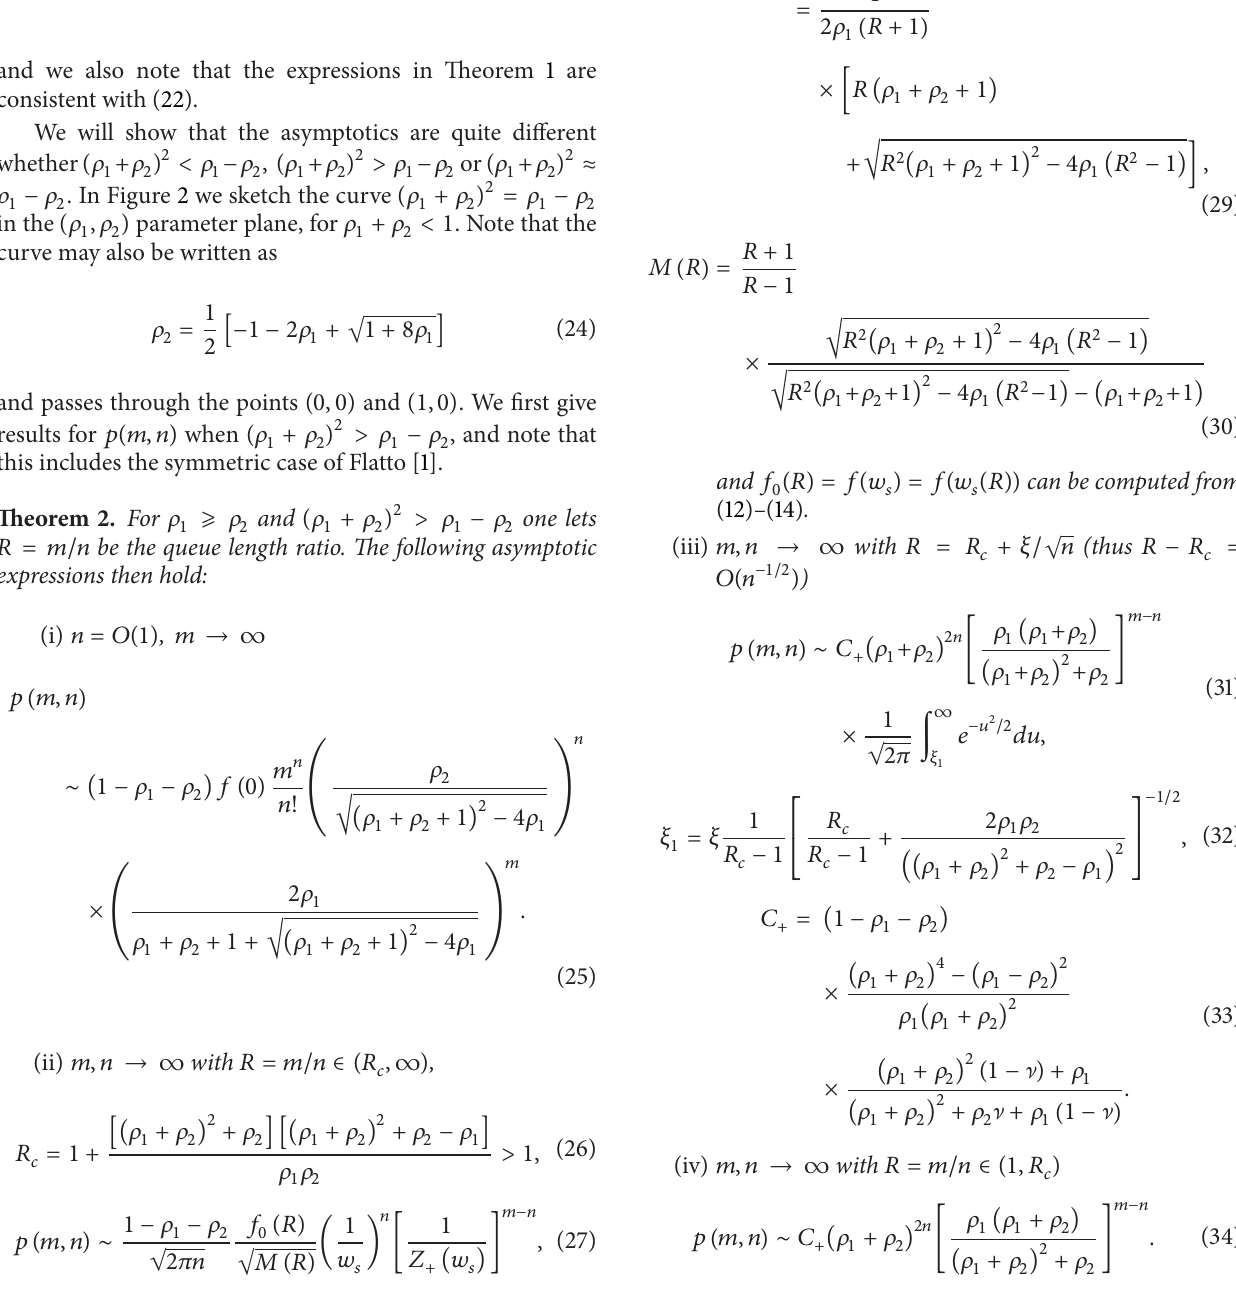
Figure2:Asketchoftheparameterdomainandthetransitioncurve + 𝜌 ) 2 = 𝜌 − 𝜌 (𝜌 1 2 1 2